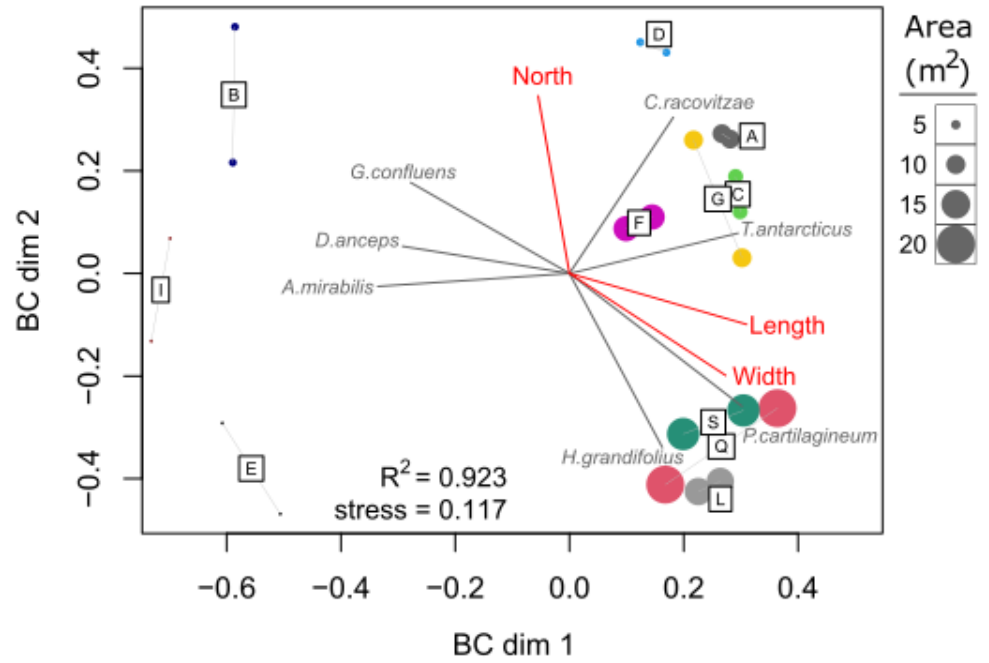
Figure 6. Non-metric multidimensional scaling (nMDS) ordination of the relative biomass of 16 algal species using Bray-Curtis dissimilarity. Each quadrat sample (two for each ice pit) is labeled and colored according to the ice pit and sized relative to the area (m 2 ) of the ice pit. Vectors indicate algal species (gray) and environmental variables (red) with significant fit to the ordination at the p < 0.01 level.